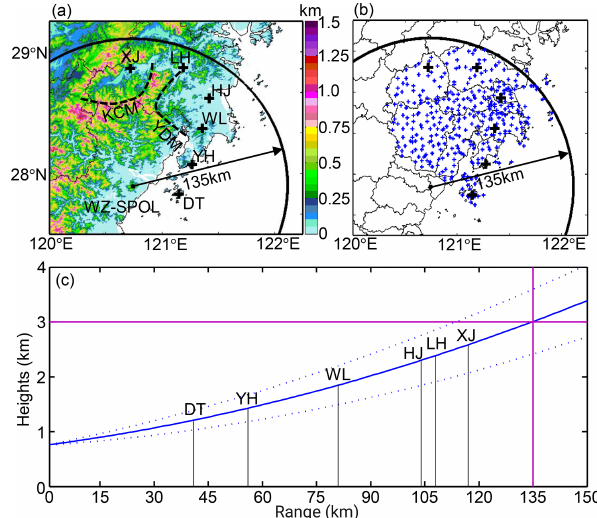
Figure 2. (a) Terrain elevation and disdrometer network around the WZ-SPOL radar (735m), (b) rain gauge network around the disas- ter center area, and (c) the height of the radar beam shown as a func- tion of measurement range in standard atmospheric conditions. The two dashed lines refer to the GWS of YDM and KCM. The black + in (a) and (b) refer to six national meteorological sites, and the blue + in (b) refers to regional meteorological sites. The solid and dotted blue curves in (c) refer to the height of the radar beam cen- ter and its radius boundaries, the vertical black lines mark the range distance of national meteorological stations (heights < 0 . 1km) from the radar, and the two orthogonal purple lines refer to the altitude of 3km and range of